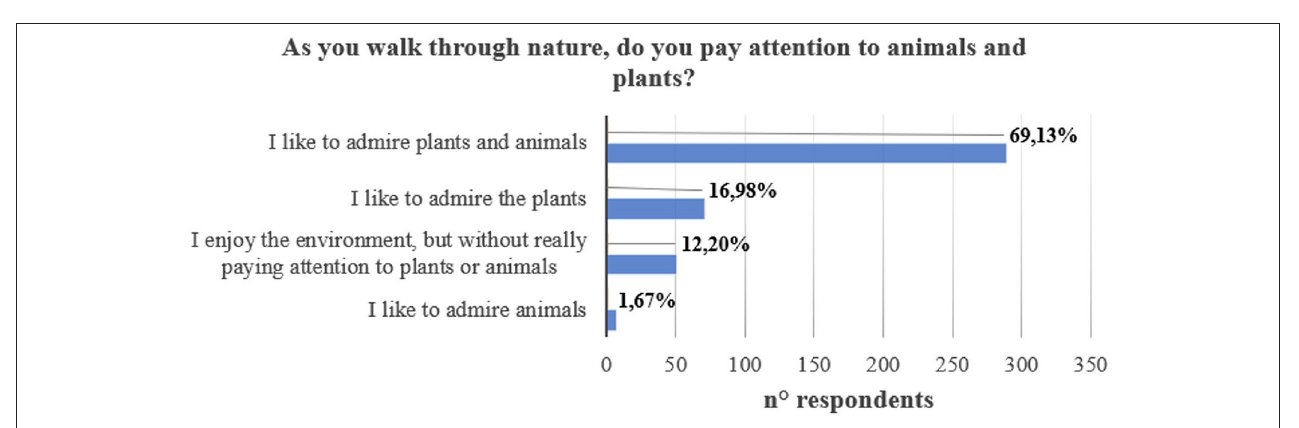
FIGURE 12 | Perception of nature in green areas. Source: Sousa R. B. et al. (2021).